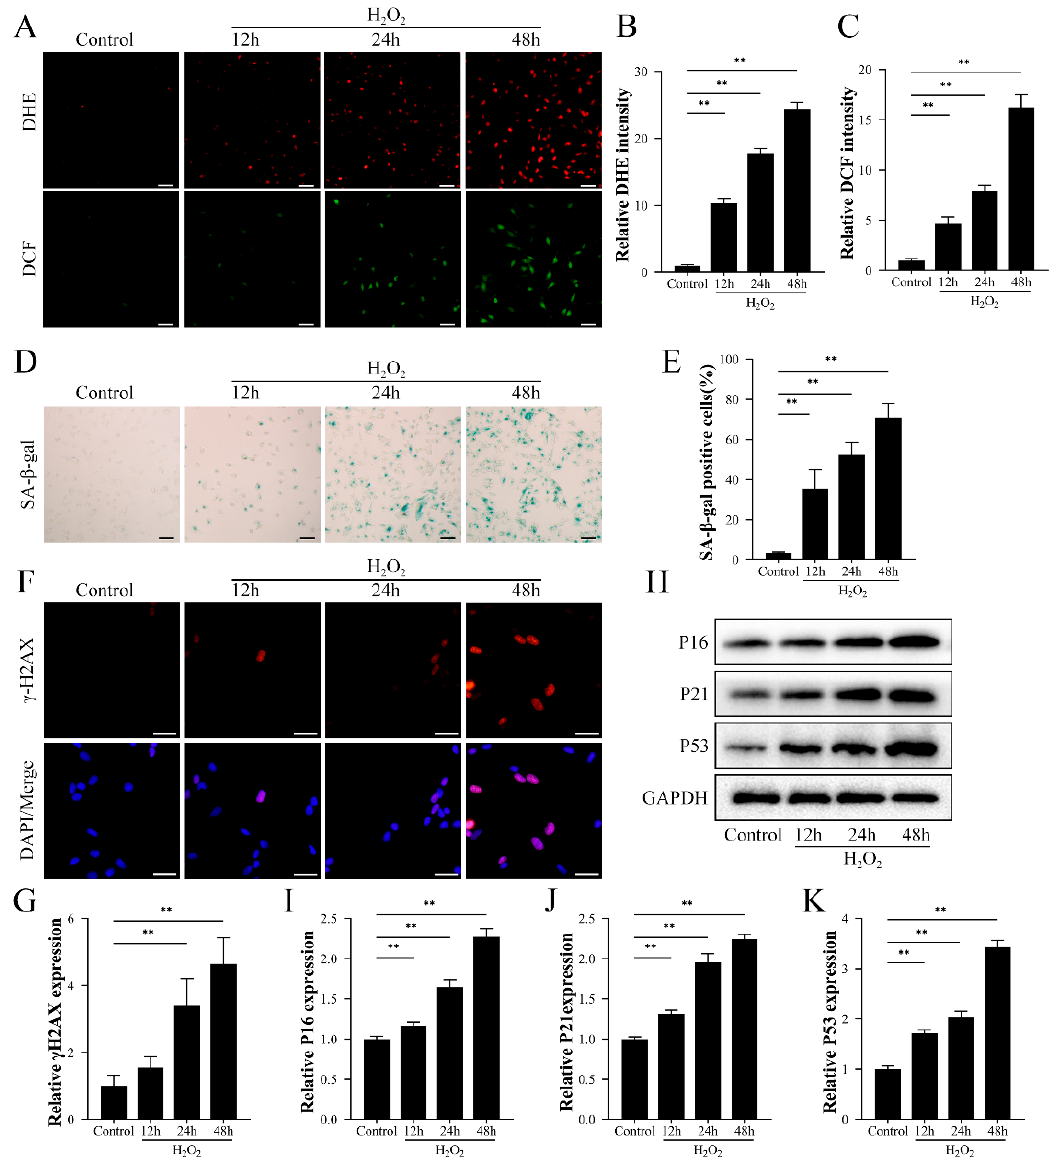
Figure 1. H 2 O 2 -induced oxidative damage induced the expression of senescence-associated factors in HK-2 cells. HK-2 cells were treated with 800 µM H 2 O 2 for 12, 24, and 48 h. ( A – C ) The levels of superoxide anion and reactive oxygen species in HK-2 cells were detected by DHE and DCF stain- ing. Scale bar = 50 µm. ( D , E ) Detection of senescence levels in HK-2 cells by SA- β -galactosidase staining. Scale bar = 50 µm. ( F ) Immunofluorescence detection of cellular senescence marker γ -H2AX expression. ( G – K ) Western blot detection of expression of senescence-related proteins P16, P21, and P53. Values are expressed as mean ± SD. The mean value is the average of the results of three replicate experiments. n = 3. ** p < 0.01.